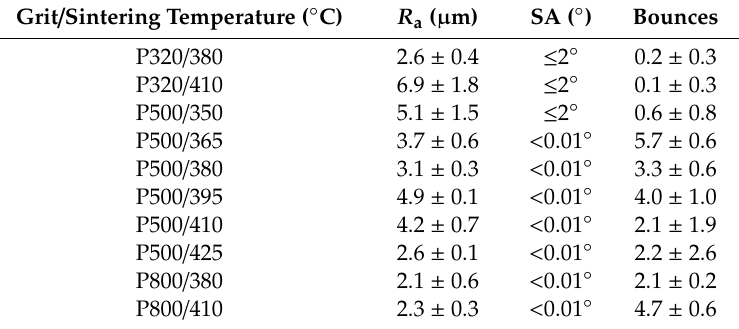
Table 3. Surface roughness ( R a ), Critical Sliding Angle (SA) and drop bounces for the sanded fluoropolymer coatings cured at di ff erent temperatures. Number of bounces > 3 are highlighted in bold. The standard deviation reflects the data scattering.